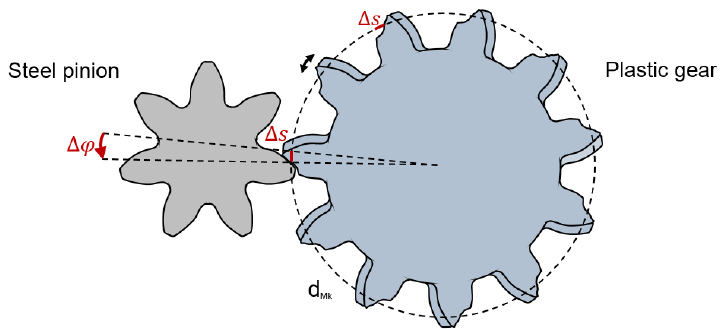
Figure 4. Tooth wear induced angular displacement between pinion and gear.